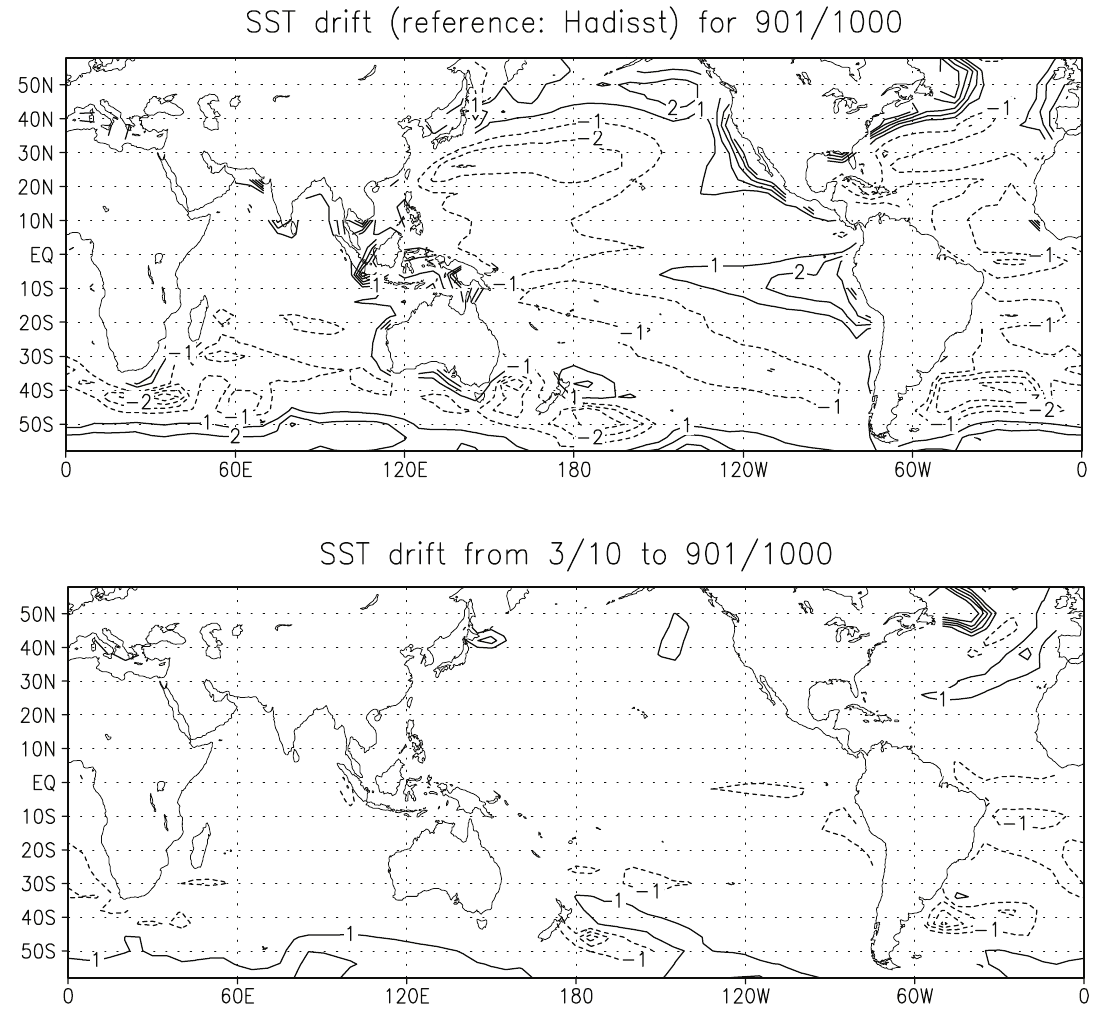
Fig. 2. Top : difference of the sea-surface temperature ( ° C) between the simulation (averaged over 901/1000) and the observation (HadISST1.1, averaged over 1900/1999). Bottom : difference of the sea-surface temperature ( ° C) between two periods of the simulation (901/1000 -